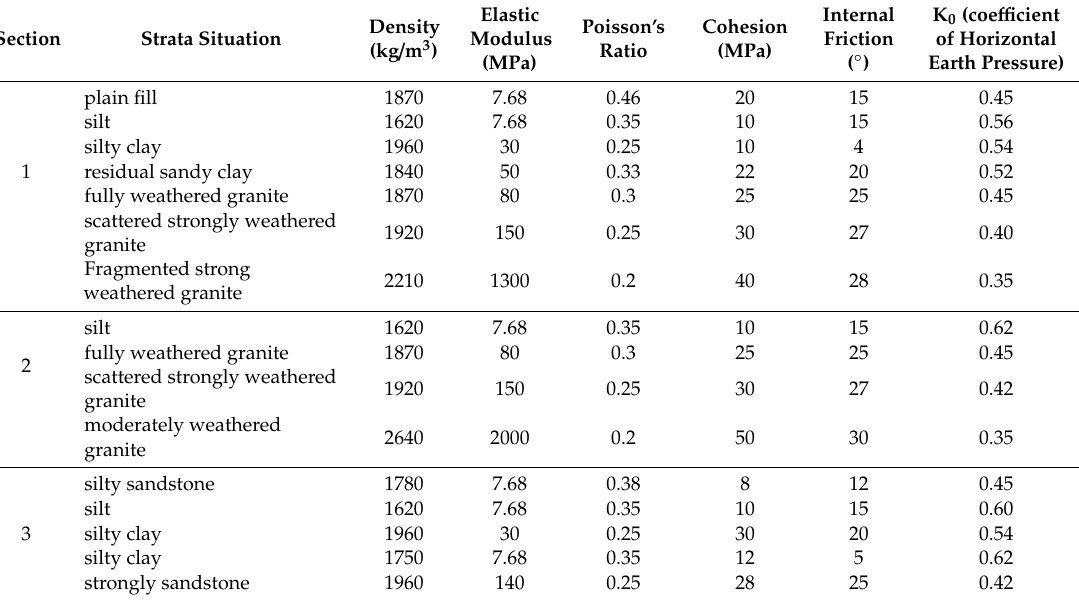
Table 4. The calculation parameters of related strata involved in the calculation.